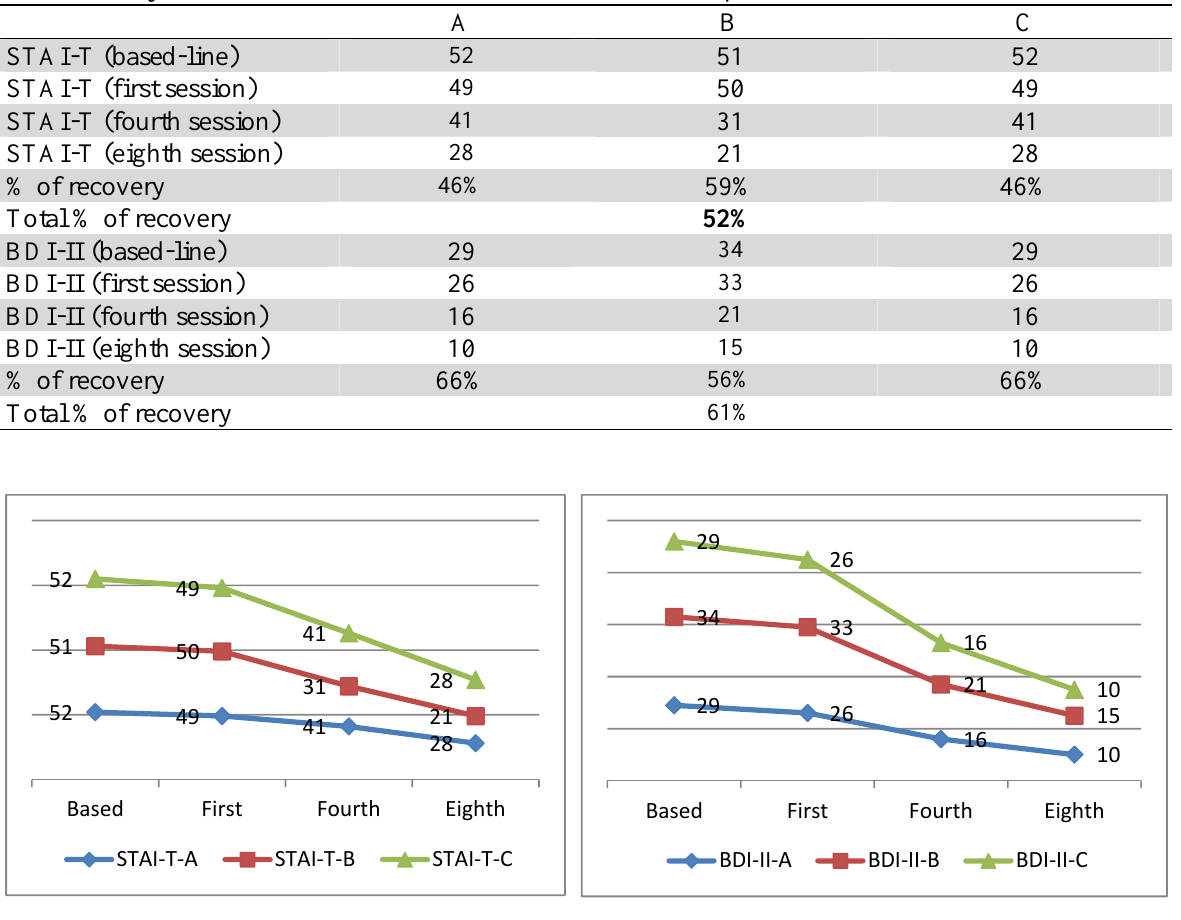
Fig. 2. The results of STAI-T and BDI-II